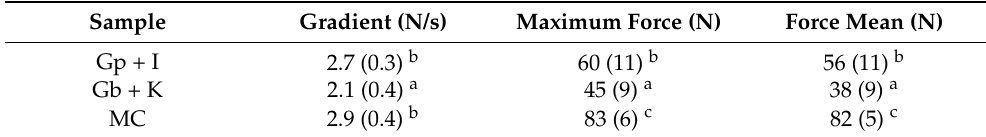
Table 1. Extrusion parameter of gels (Gp + I: percine gelatin plus iota carrageenan; Gb + K: bovine gelatin plus kappa carrageenan; MC: